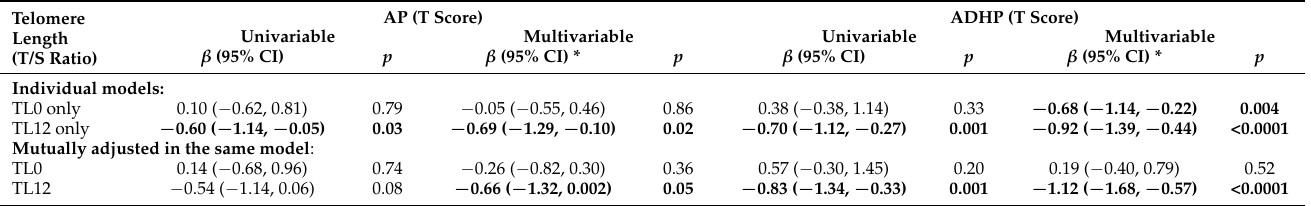
Table 2. Associations between telomere length in infancy and ADHD symptoms at age two